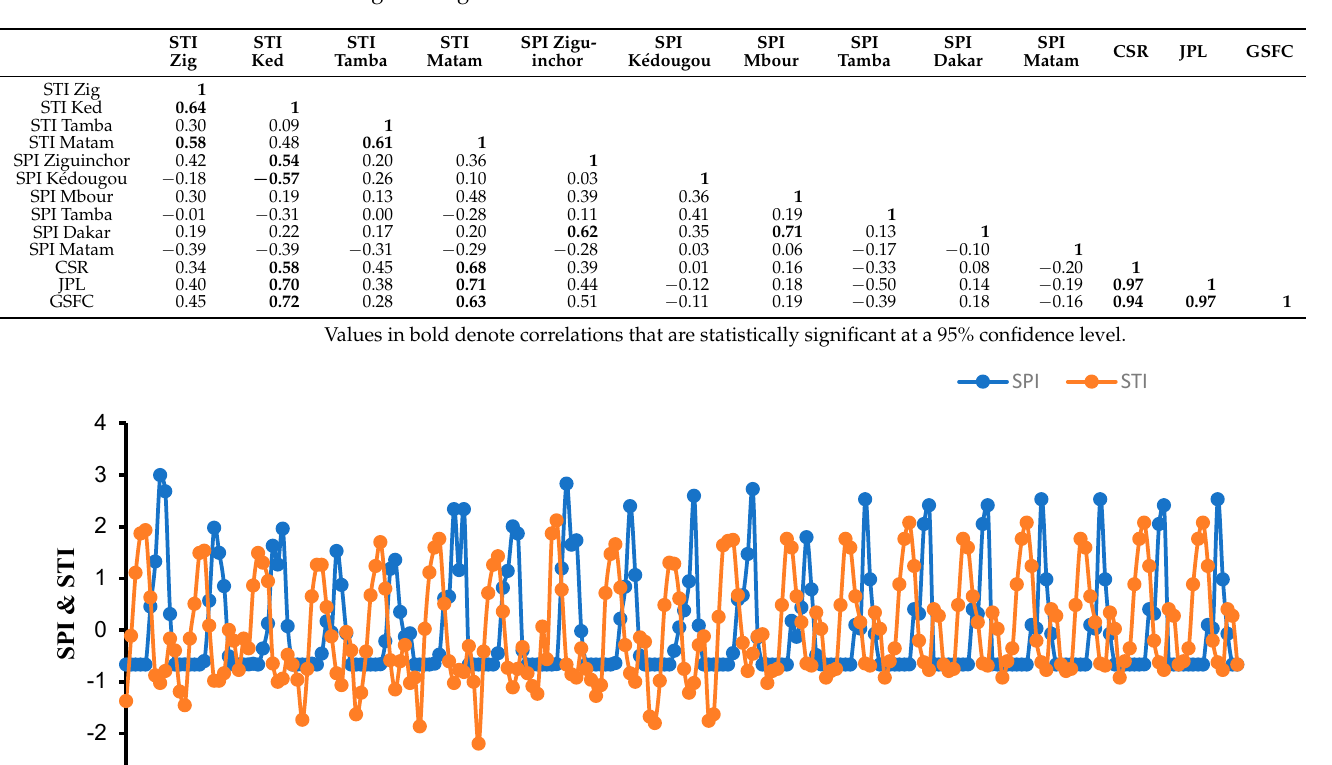
Table 2. Correlation linear (Pearson) matrix of terrestrial water storage and drought indices on the Senegalese regions.